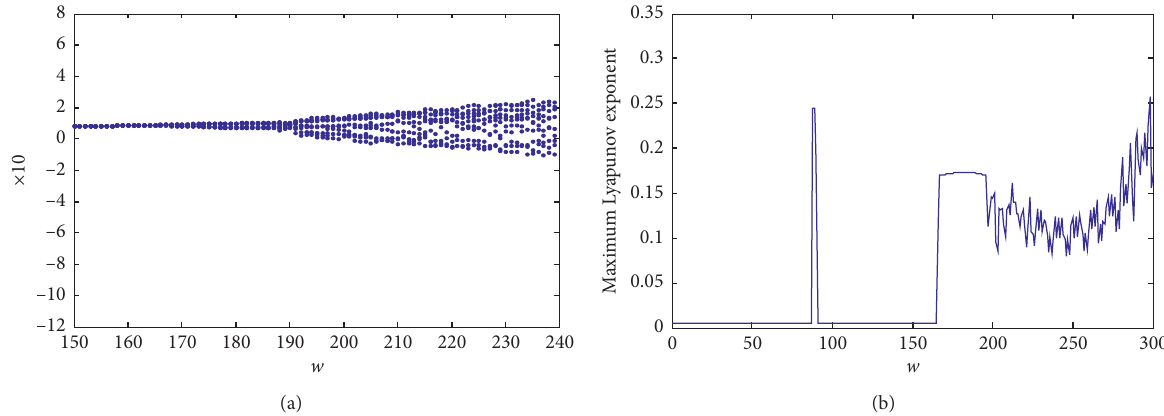
Figure 20: (a) Vibrational bifurcation diagram curve with k